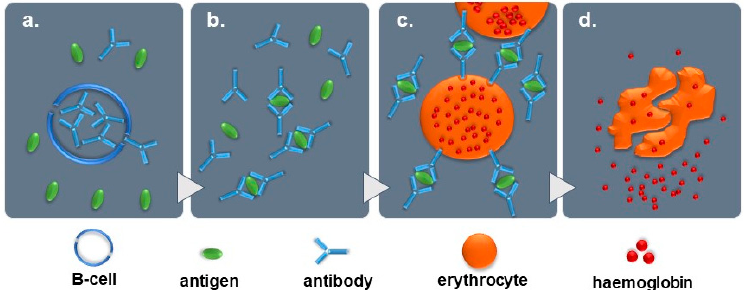
Figure 8. Simplified presentation of the proposed pathophysiological mechanism involving the immunohaemolytic reaction during the Paxillus syndrome. ( a ) Release of antibodies from B-cells, ( b ) antigen-antibody reaction, ( c ) attachment of immune complex to erythrocyte membrane, ( d ) disruption of erythrocytes